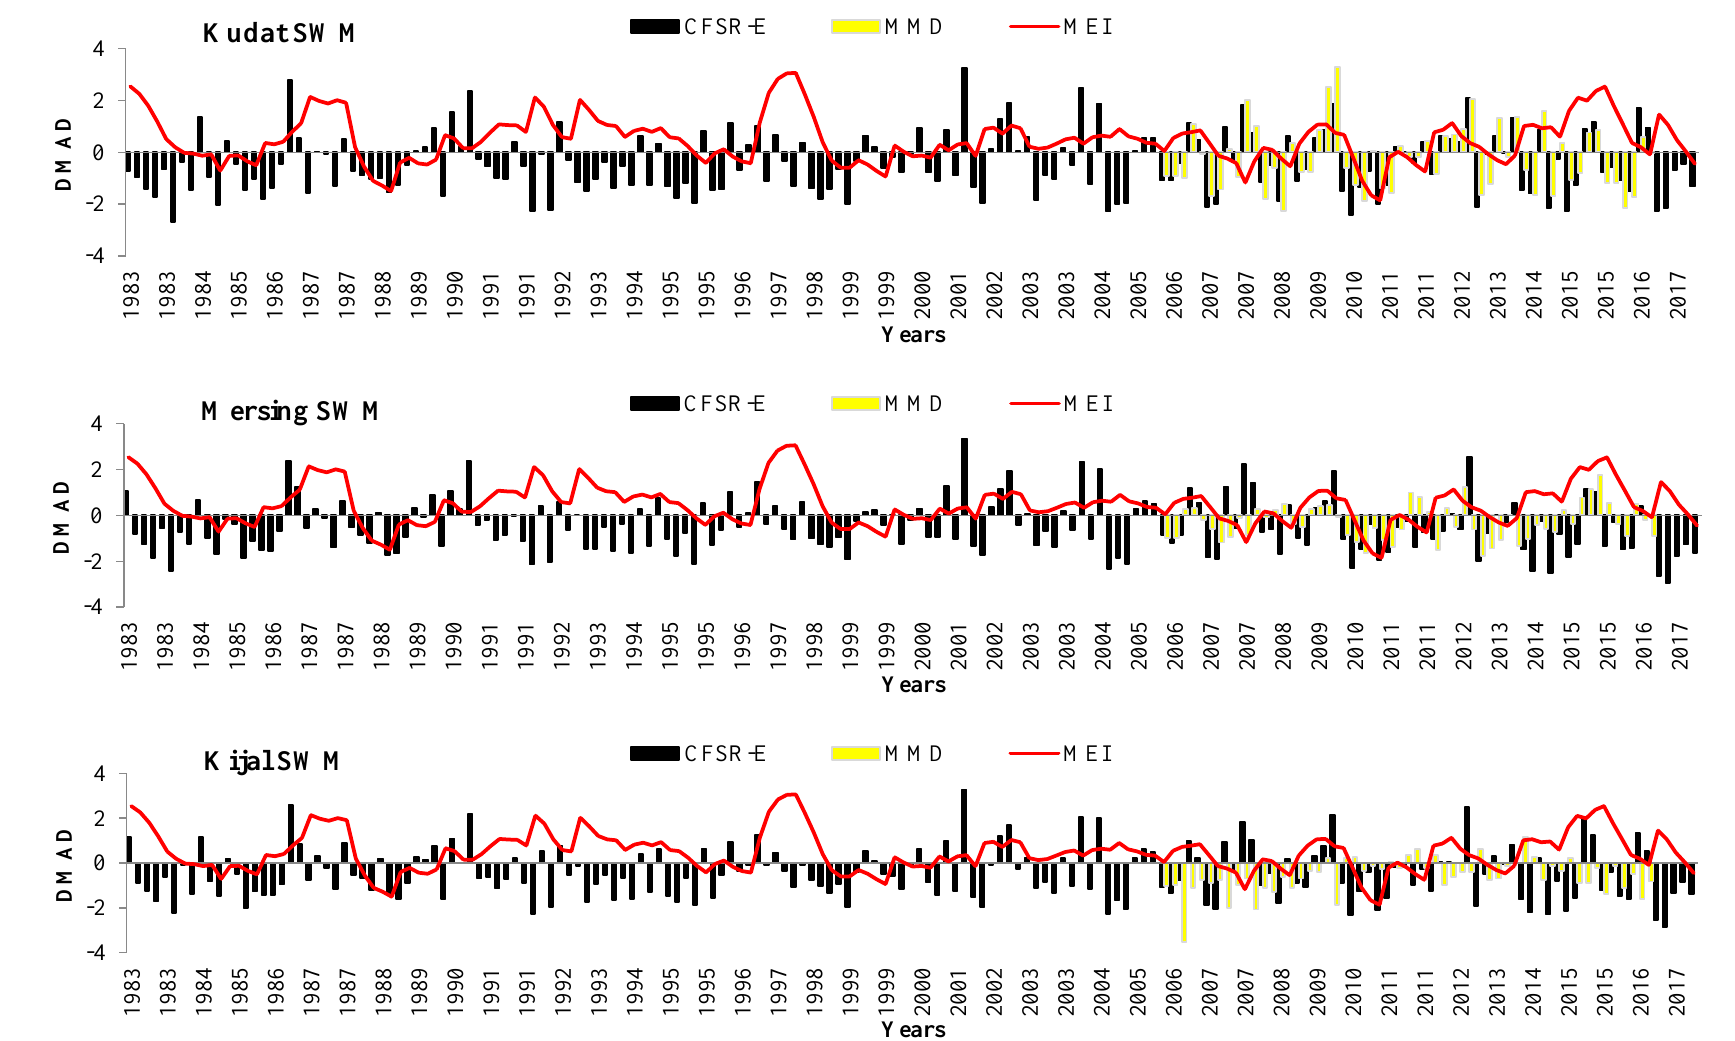
Figure 3. The DMAD for CFSRE and MMD data during the Southwest monsoon (SWM) season.